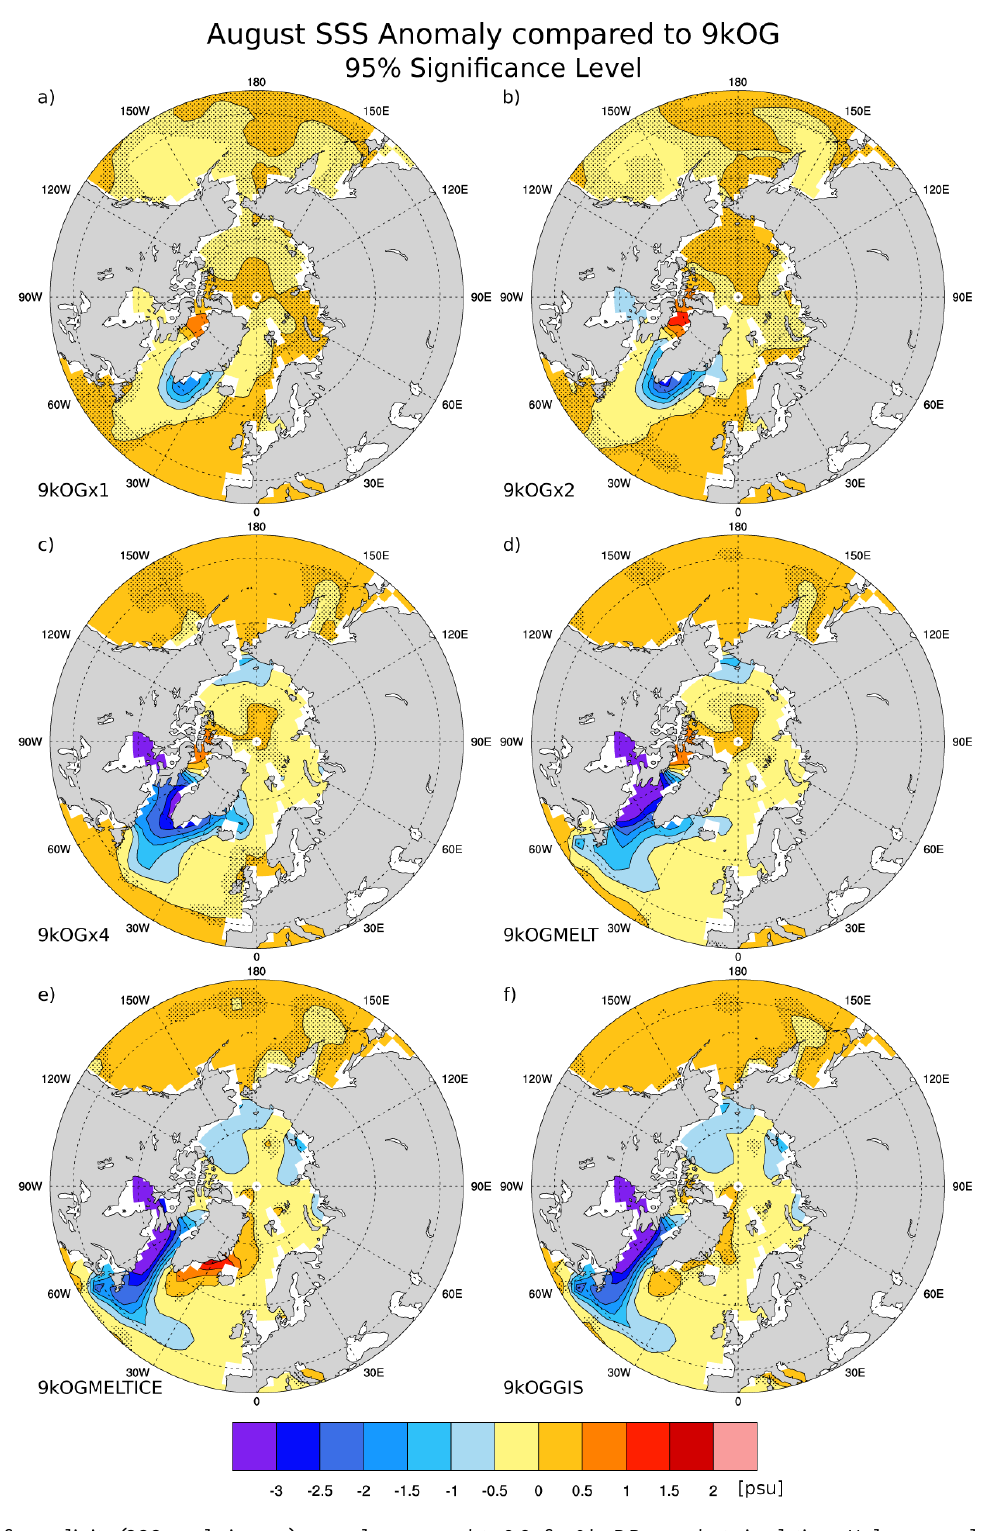
Fig. 3. Sea surface salinity (SSS, scale in psu.) anomaly compared to OG for 9kaBP snapshot simulations. Values are calculated from the last 100yr of each experiment. Shaded area denotes insignificant changes compared to 9kOG according to a Student’s t test. (a) 9kOGx1 SSS anomaly for GIS melt (13mSv). (b) 9kOGx2 SSS anomaly for GIS melt (26mSv). (c) 9kOGx4 SSS anomaly for GIS melt (52mSv). (d) 9kOGMELT SSS anomaly for LIS melt (0.09Sv). (e) 9kOGMELTICE SSS anomaly for LIS melt (0.09Sv)+remnant ice sheet (albedo + topography). (f) 9kOGGIS SSS anomaly for LIS melt+remnant ice sheet+additional GIS melt